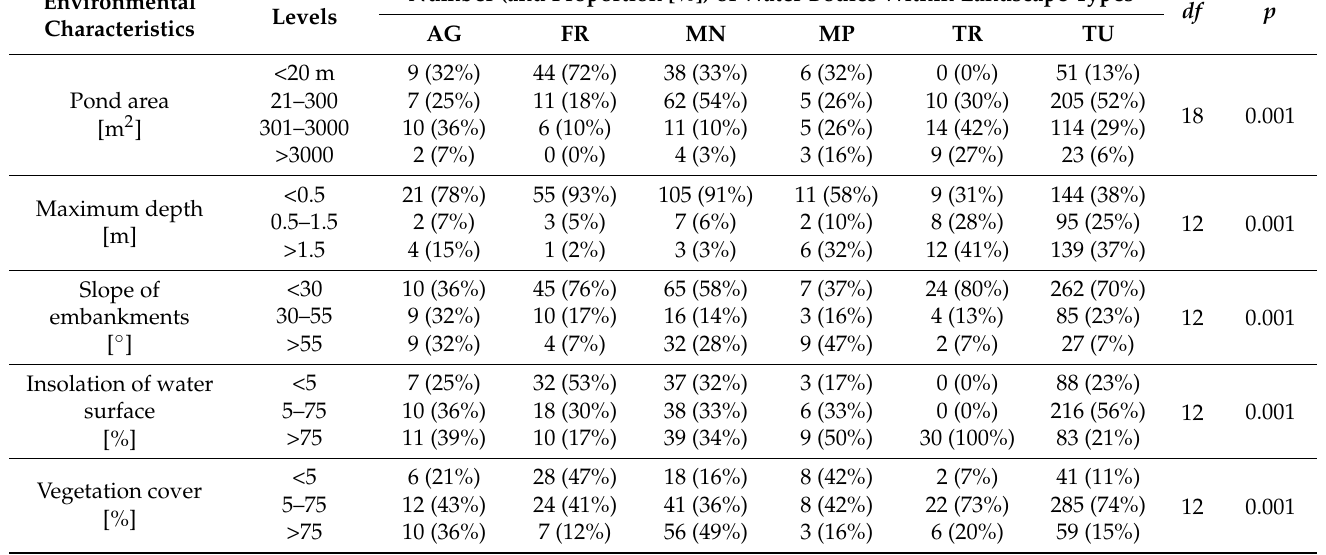
Table 3. Comparison of water body characteristics between landscape types. AG = agricultural landscape; FR = forest landscape; MN = mountain landscape; MP = meadows and pastures; TR = tech- nically reclaimed spoil banks; TU = technically unreclaimed spoil banks. [%]—Proportion of water bodies with certain characteristics belonging to each landscape type (column); df = degrees of freedom of the chi-square tests; p = p -values of the chi-square tests corrected for multiple testing using the Holm–Bonferroni